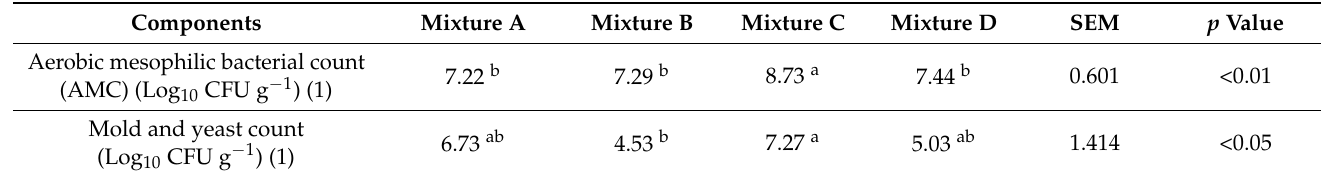
Table 4. Bacterial and mold and yeast count (Log 10 CFU g − 1 ) of ensiled mixtures at the end of 90 days fermentation ( n = 20). Components Mixture A Mixture B Mixture C Mixture D SEM Aerobic mesophilic bacterial